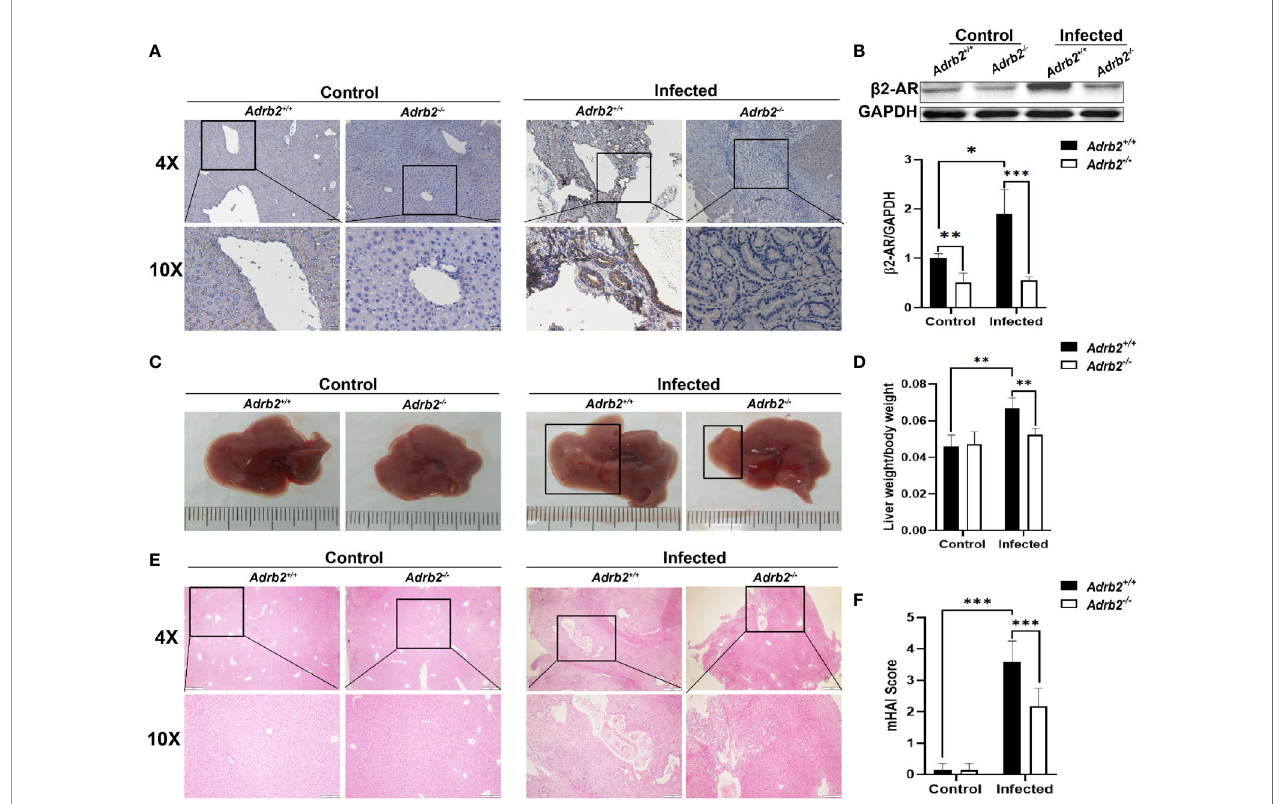
FIGURE 1 | b 2-AR de fi ciency alleviates hepatobiliary damage in mice infected with Clonorchis sinensis . The experimental setup of the in vivo model used n = 4 mice in the control group and n=6 mice in the infected group. The mice were divided into control Adrb2 +/ + , Adrb2 − / − and infected Adrb2 +/ + , Adrb2 − / − . (A) The Immunohistochemistry analysis of the expression of b 2-AR in the liver of control and C. sinensis infected mice. The expression of b 2-AR signi fi cantly increases in infected Adrb2 +/ + than control Adrb2 +/ + ; however, there is a low or no expression of b 2-AR respectively in infected Adrb2 − / − and control Adrb2 − / − mice. (B) Western blot results con fi rm the result of the expression of b 2-AR shown by IHC. The expression of b 2-AR signi fi cantly increases in infected Adrb2 +/ + compared to the other groups. (C) The pictures of the liver of control and infected mice. The images of liver injury in infected Adrb2 +/ + is much more severe than that observed in infected Adrb2 − / − . The liver injury in infected Adrb2 − / − is limited to a small part of the liver. (D) The liver weight/body weight ratio increases in infected Adrb2 +/ + compared to the others groups. (E, F) The Hematoxylin and Eosin analysis of the liver sections revealed that the damage in infected Adrb2 − / − is limited to a small part of the liver with limited necrosis of liver cells, while the liver of infected Adrb2 +/ + shows severe liver injury characterized by the necrosis of tissues in hepatocytes and around the bile duct. Compared with indicated groups, * P < 0.05, ** P < 0.01, *** P <